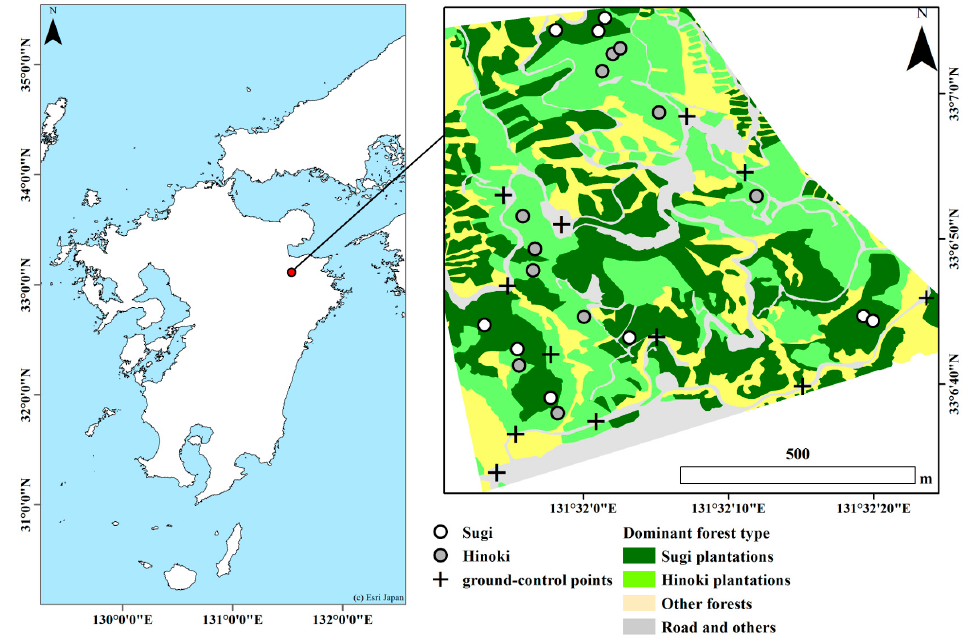
Figure 1. Location of the study area. The municipal boundaries provided by ESRI Japan were used as the country border. The forest cover map was created by visual interpretation based on aerial photographs acquired by a lightweight unmanned aerial vehicle photographs acquired by a lightweight unmanned aerial vehicle (UAV).